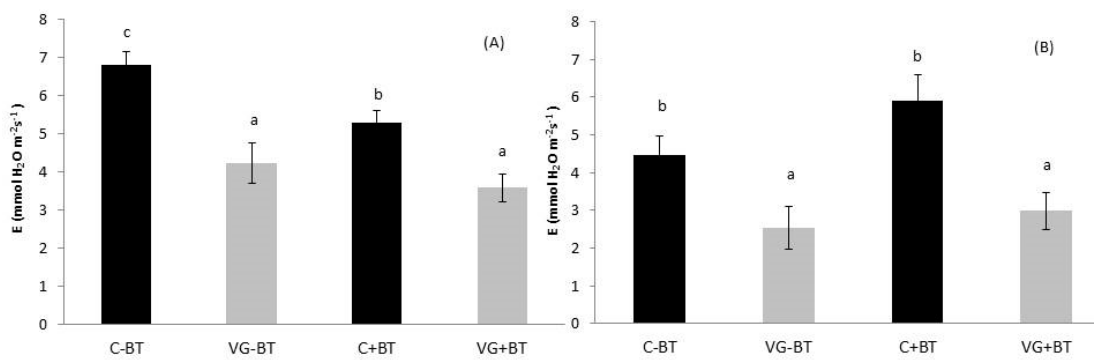
Figure 3. Transpiration rate (E) measured at harvest in the years 2013 ( A ) and 2014 ( B ) on fully expanded Falanghina leaves sprayed with anti-transpirant Vapor Gard ® (VG) at 2% or left unsprayed (C) with or without bunch thinning (BT). Data are averages of 10 replicates ± SE. Same letter indicates not significant differences at Duncan post hoc test ( p < 0.05).